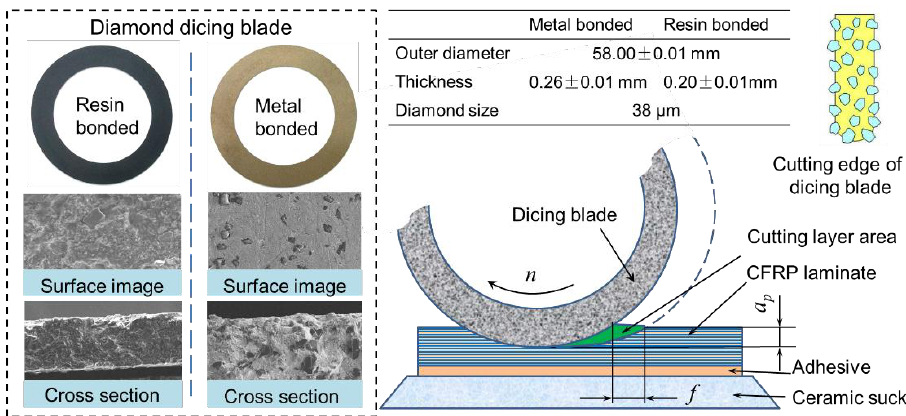
Figure 3. Structure of dicing blade and schematic diagram of cutting process.